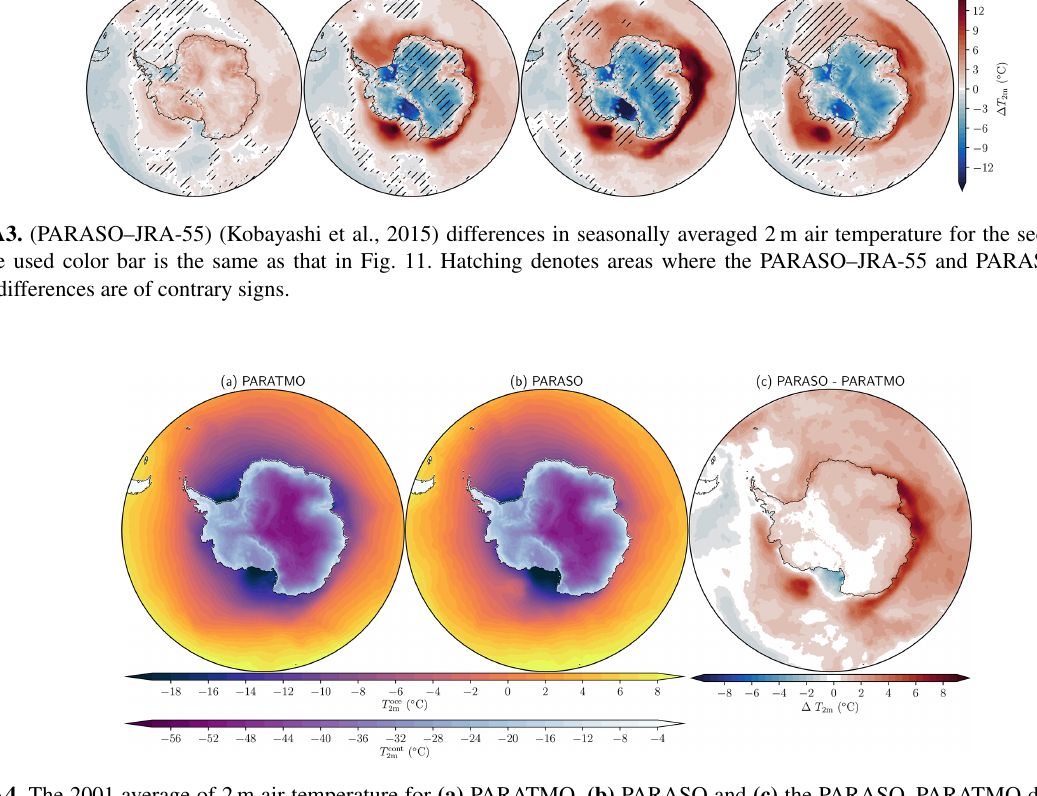
Figure A4. The 2001 average of 2m air temperature for (a) PARATMO, (b) PARASO and (c) the PARASO–PARATMO difference. Note that in panels (a) – (b) , distinct color scales are used for the ocean (“oce”) and continent (“cont”).